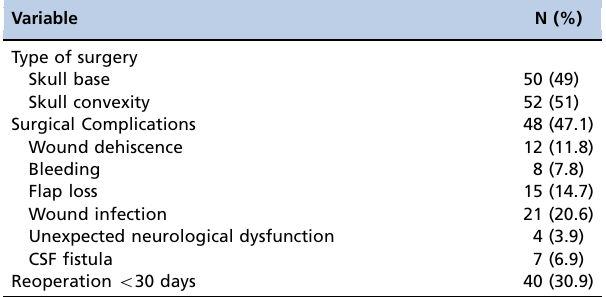
Table 2 - Surgical procedures.